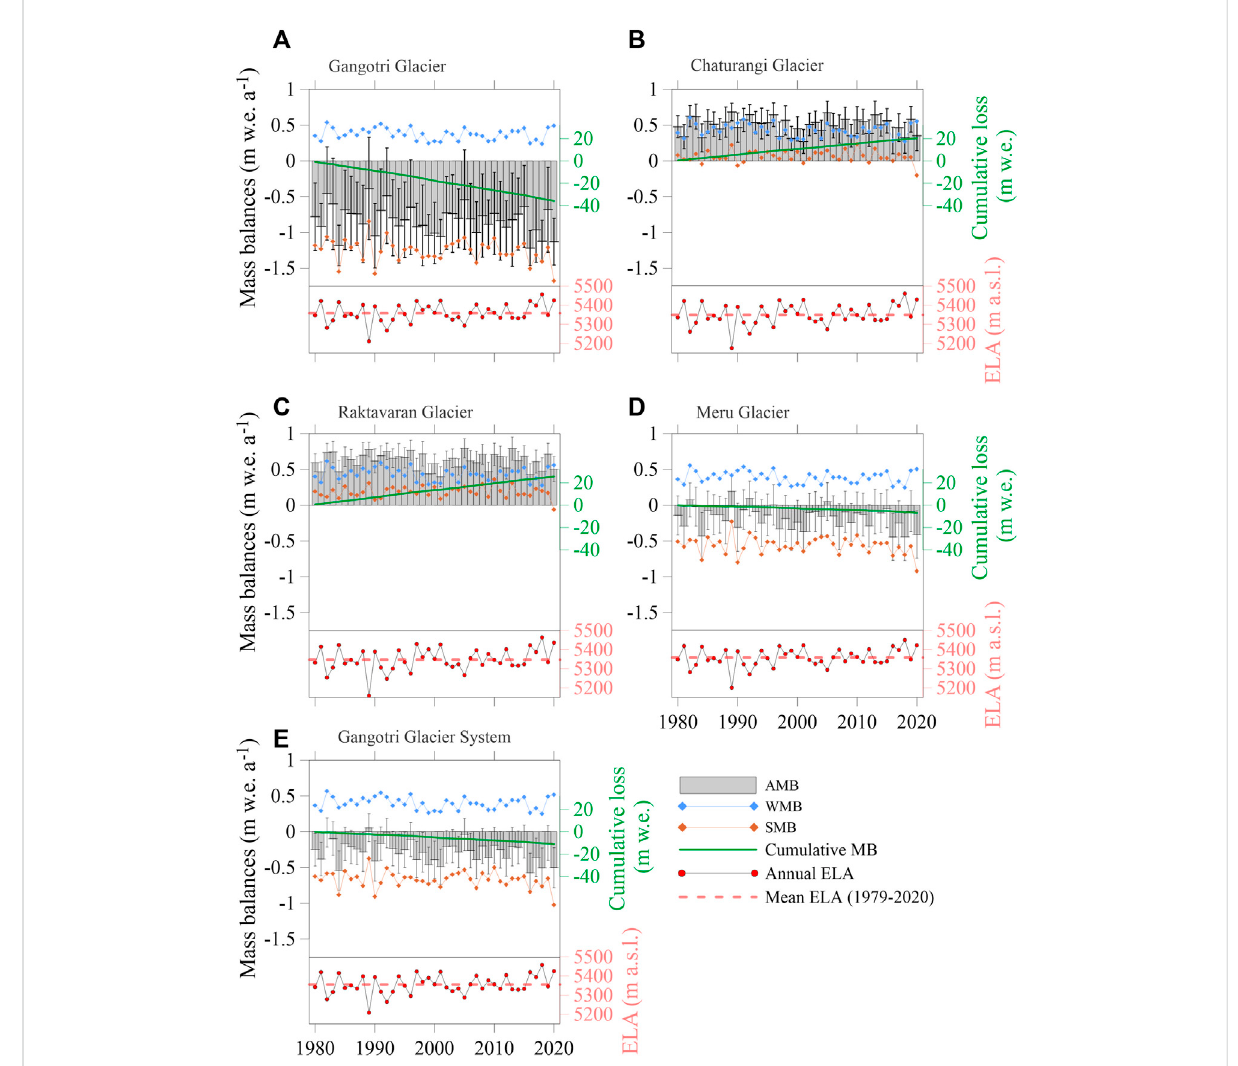
FIGURE 5 Annual and seasonal modelled MBs for (A) Gangotri Glacier, (B) Chaturangi Glacier, (C) Raktavaran Glacier, (D) Meru Glacier and (E) Gangotri Glacier System. Grey bars represent annual MBs along with the associated uncertainties. Blue and red-brown rhombus represent the winter and summer MBs, respectively. Green lines show the cumulative MBs, red dots with black boundaries show the annual ELAs, and the red dashed lines show the mean ELAs over 1979 – 2020 for the respective